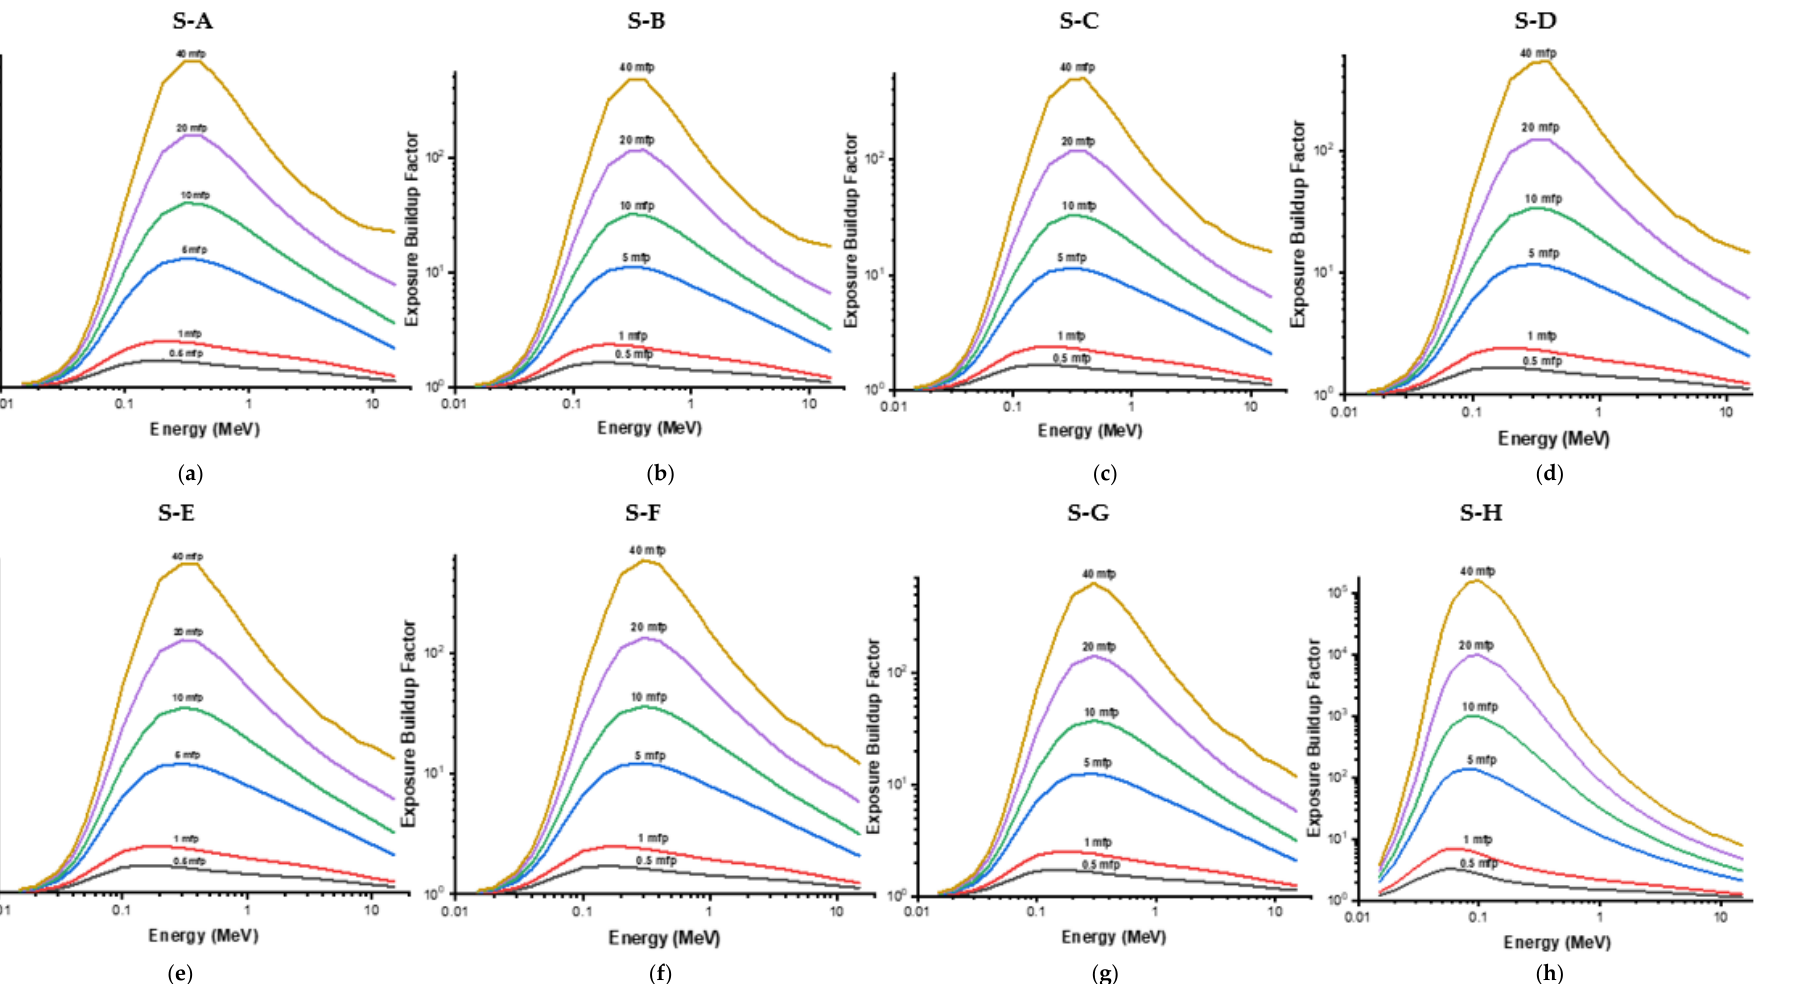
Figure 3. EBF of Sample A, B, C, D, E, F, G and H, respectively for range 0.015–15 MeV at different mfp's. ( a ) is S-A, ( b ) is S-B, ( c ) is S-C, ( d ) is S-D, ( e ) is S-E, ( f ) is S-F, ( g ) is S-G and ( h ) is S-H.